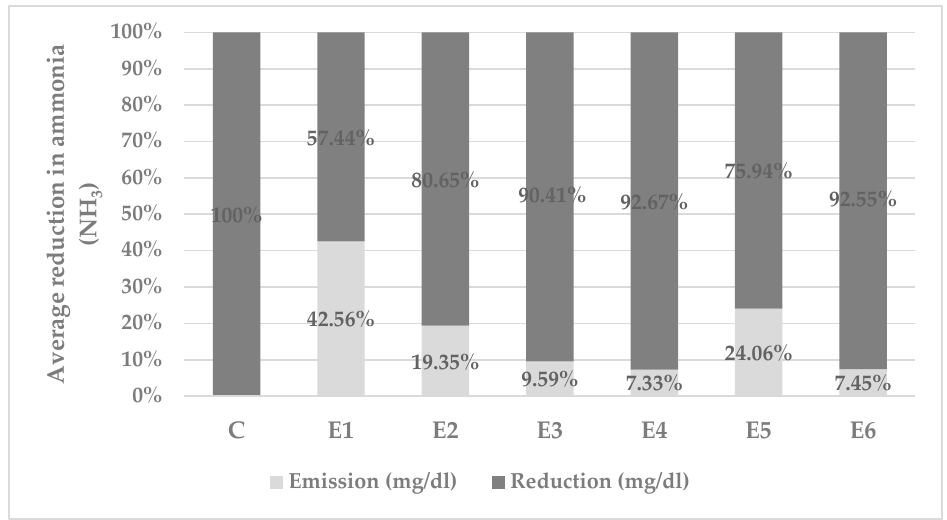
Figure 2. Average reduction in ammonia (NH 3 ) from cattle manure during the study period (%).